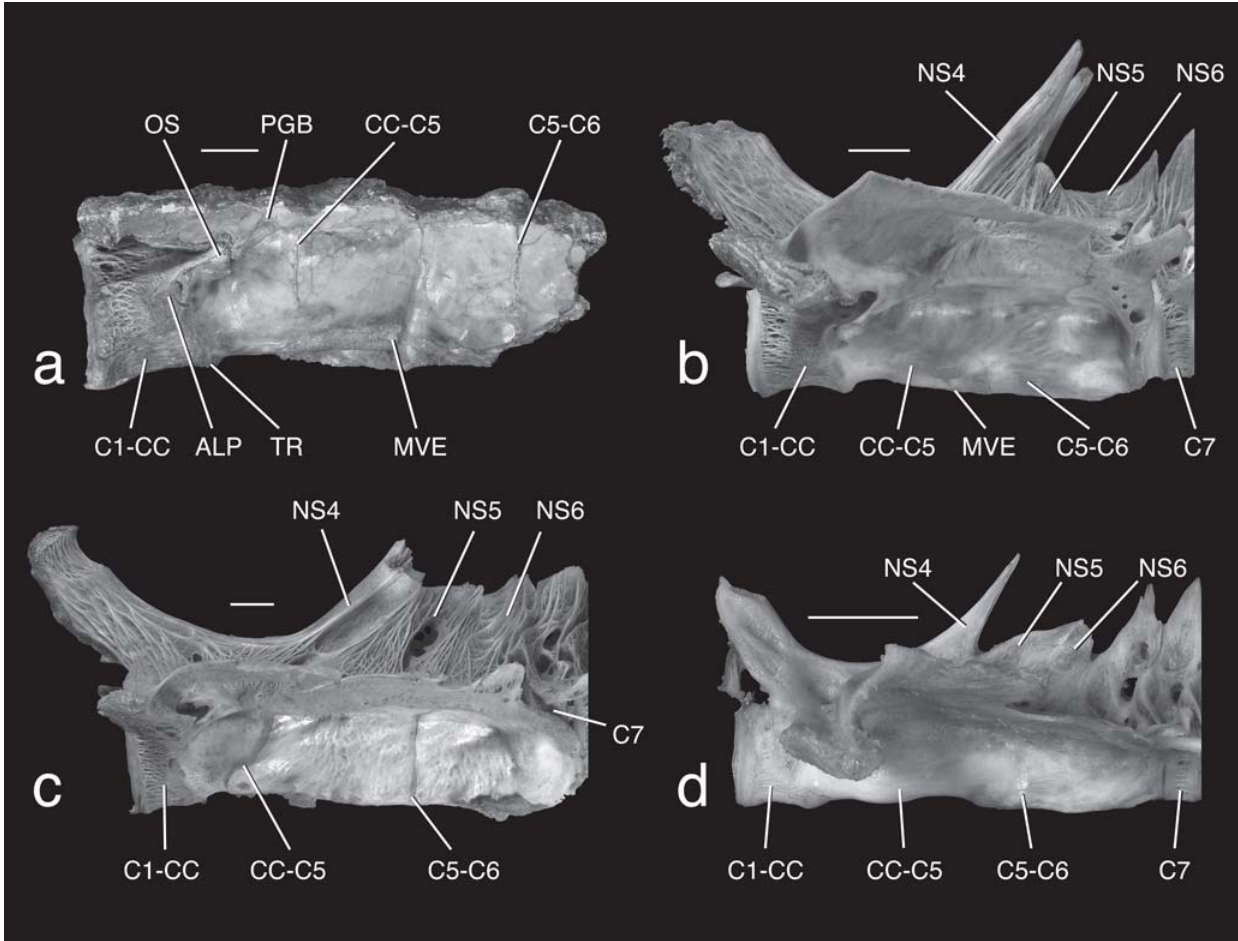
Fig. 4. Weberian complex in left lateral view of the fossil and modern Brachyplatystoma species, a. B. promagdalena , IGM183062, b. B. filamentosum , DU F1052, c. B. rousseauxii , DU F1078, d. B. vaillantii , DU F1034. Scale bars equal to 1 cm. Abbreviations as in Figs. 1 and 2 plus : NS5, neural spine of fifth vertebra; NS6, neural spine of sixth